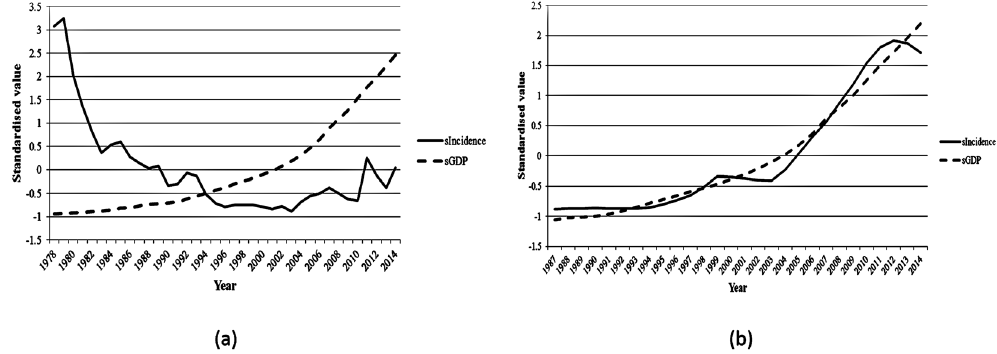
Figure 2. ( a ) The time plot of the standardised scarlet fever incidence and GDP; ( b ) The time plot of the standardised syphilis incidence and